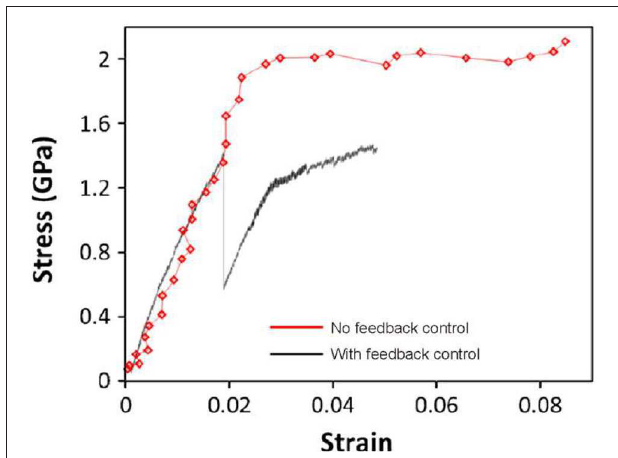
FIGURE 3 | Stress-strain curves derived from tensile tests on silver nanowires of 118nm diameter. The red curve is referred to a test where the load sensor is allowed to move, while the black curve was derived during a test where a displacement feedback control of the load sensor was implemented. Reprinted with permission from Pantano et al. (2015). Copyright 2015,